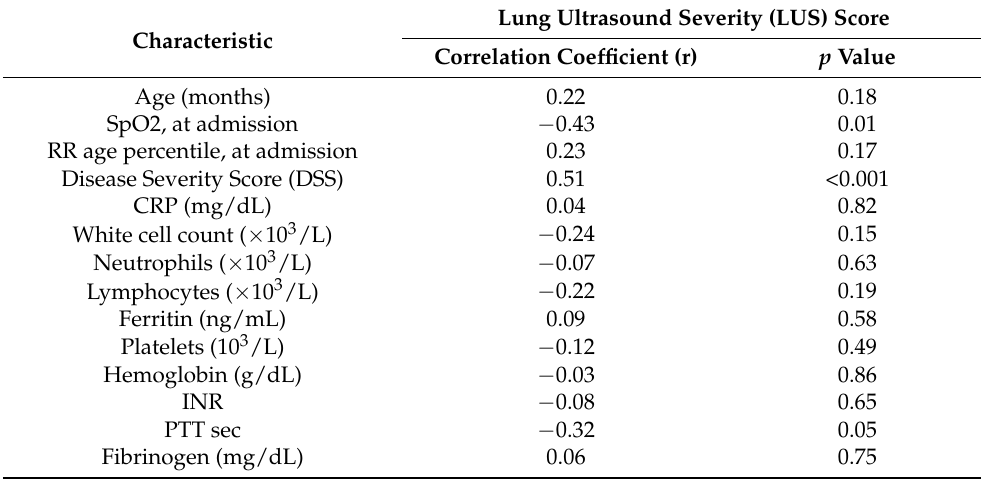
Table 3. The correlation between the LUS score and the disease severity score with the clinical and laboratory parameters in children hospitalized for COVID-19 infection.